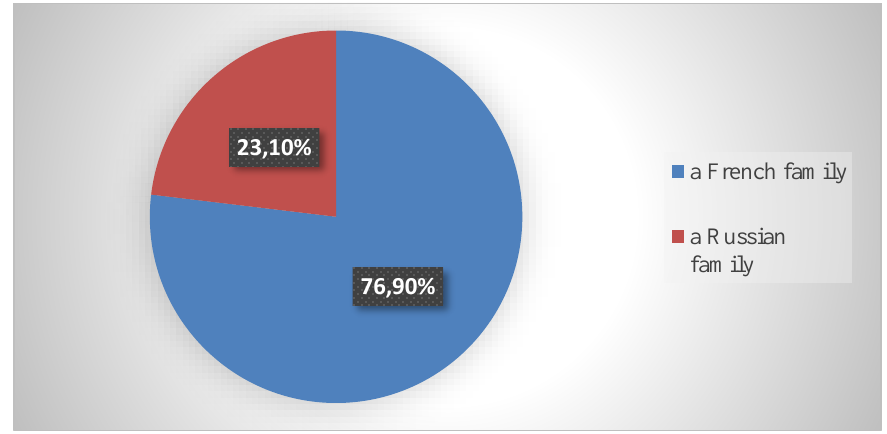
Fig 4. The respondents’ answers about the families depicted in the pictures.